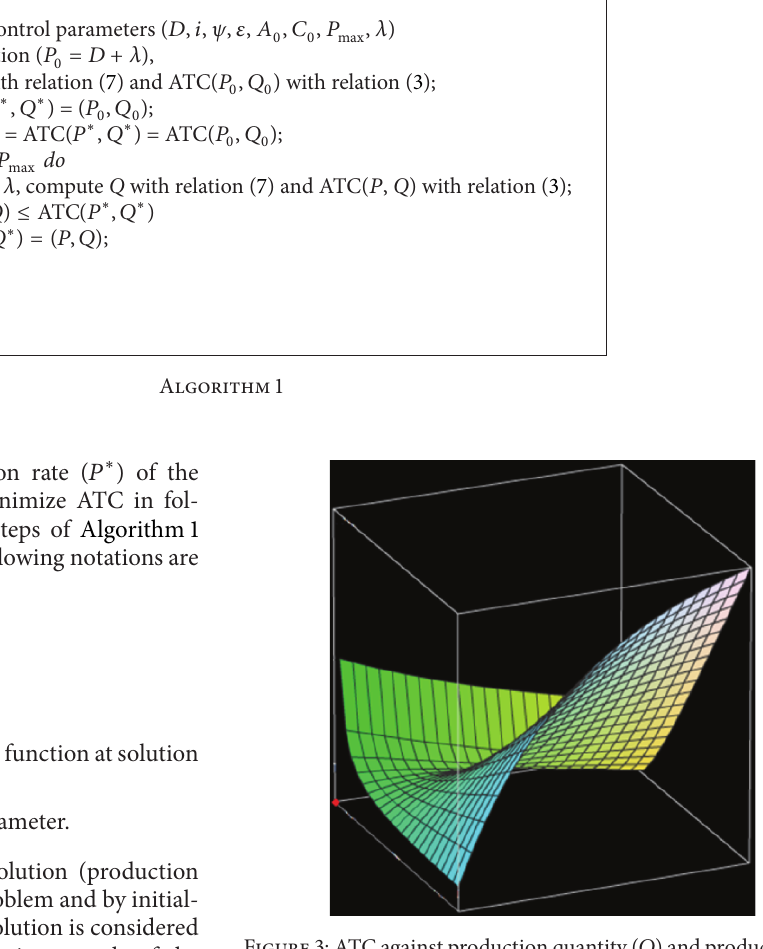
Figure 3: ATC against production quantity ( 𝑄 ) and production rate ( 𝑃 ). 𝜓 = 0.1 , 𝜆 = 1